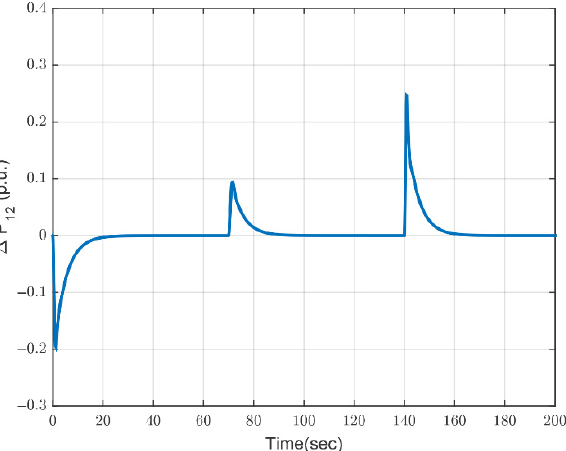
Figure 11. Mechanical power output deviations of proposed LFC controller for random step load disturbance.